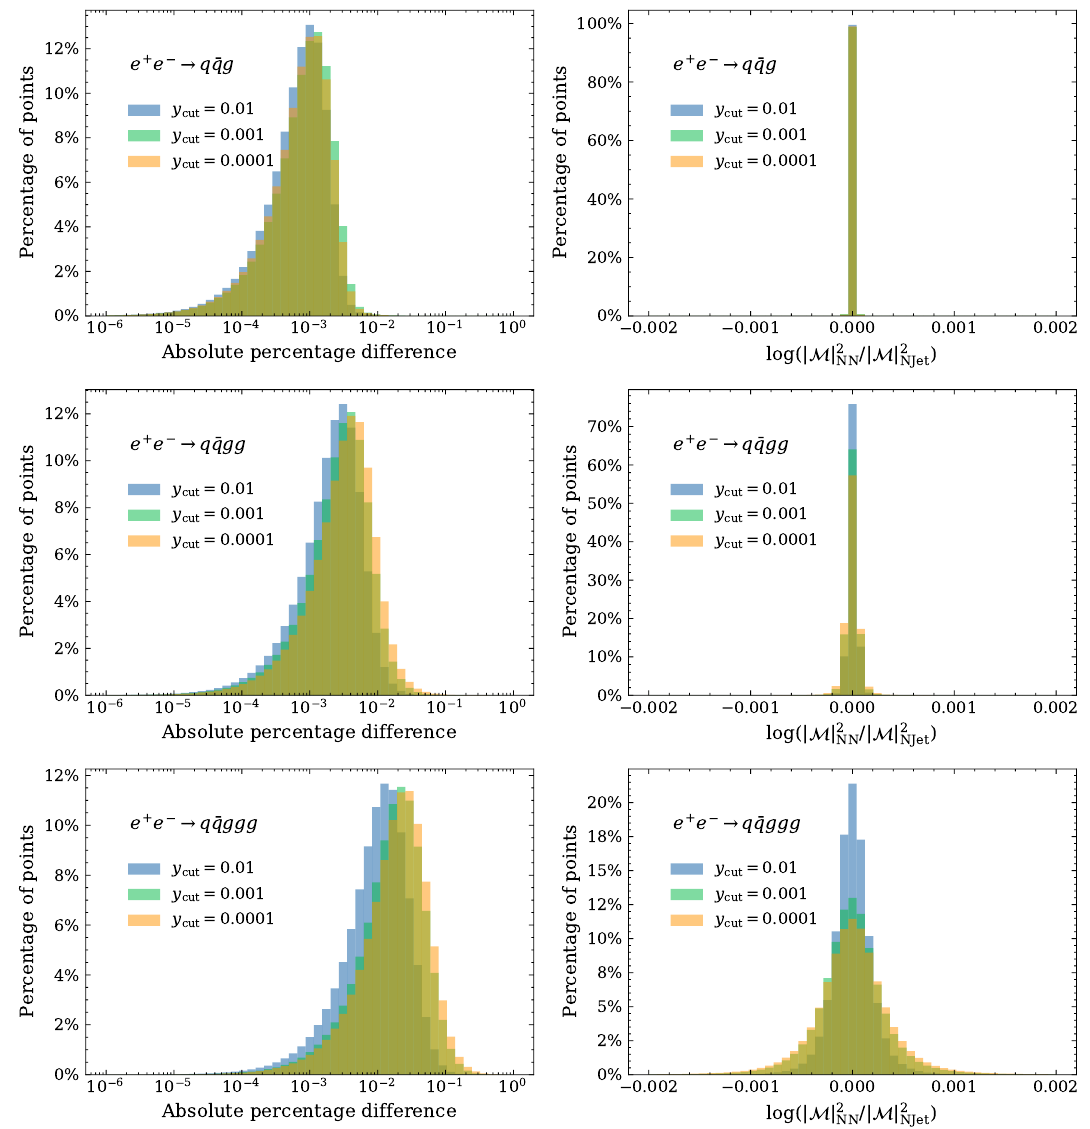
Figure 3 . Error distributions for all three multiplicities (rows) and global phase-space cuts. Left: absolute percentage difference between NN prediction and NJet . Right: ratio of matrix elements from NN and NJet . Axis scales have been fixed for each column of subplots for ease of comparison between